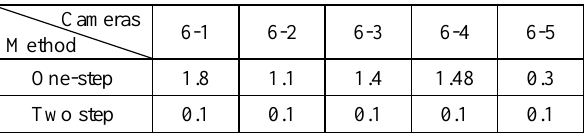
Figure 10. Relative distance from the GPS antenna center to perspective centers of cameras Figure 9. Relative distance from the perspective center of the reference camera (camera “0”) to the other cameras Table 3. Standard deviations of Relative distance from GPS antenna center to perspective centers of cameras (unit: Table 1. Standard deviations of relative distance from perspective center of referencing camera (camera “0”) to the other cameras (unit: cm)